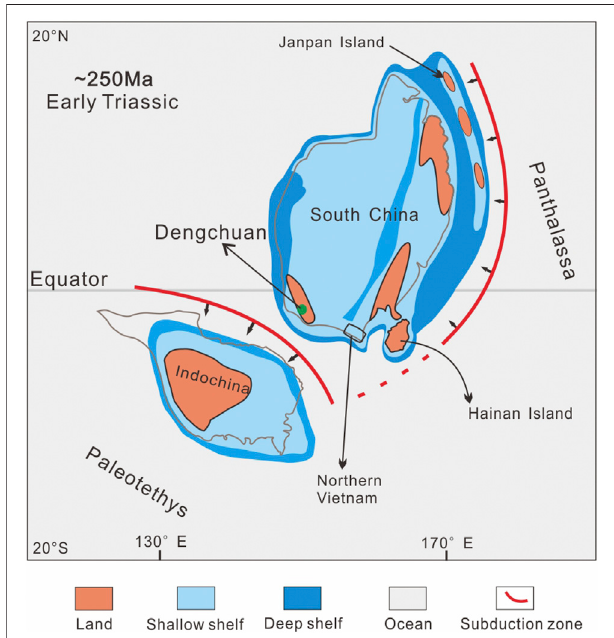
FIGURE 13 | Paleogeography reconstruction diagram of the South China Craton – Indochina Block during ~250 Ma (modi fi ed after Li et al., 2006; Ma et al., 2009; Cocks and Torsvik, 2013; Hu et al., 2017).